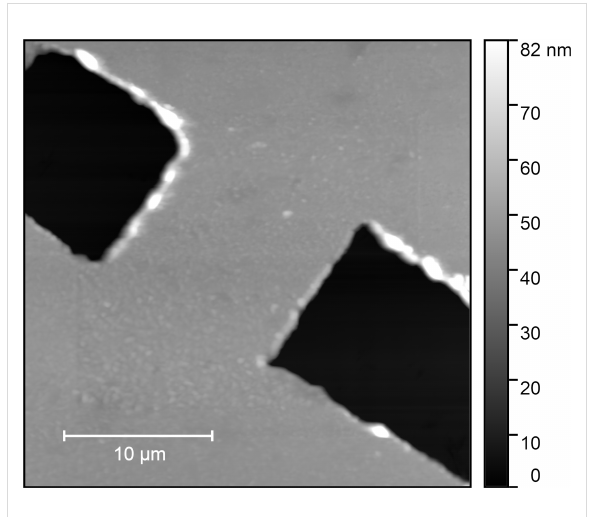
Figure 1: An AFM image of a 10 × 10 μ m 2 constriction in a 48 nm thin silver film on a sapphire substrate. The total area of the AFM image is 30 × 30 μ m 2 . Two cuts (black channels) split the silver layer (grey) into two parts, connected only by the bridge depicted in the image. Under the application of a current, the metal heats up due to the Joule effect. The presence of a constriction in the metal (the bridge) results in a localised heating